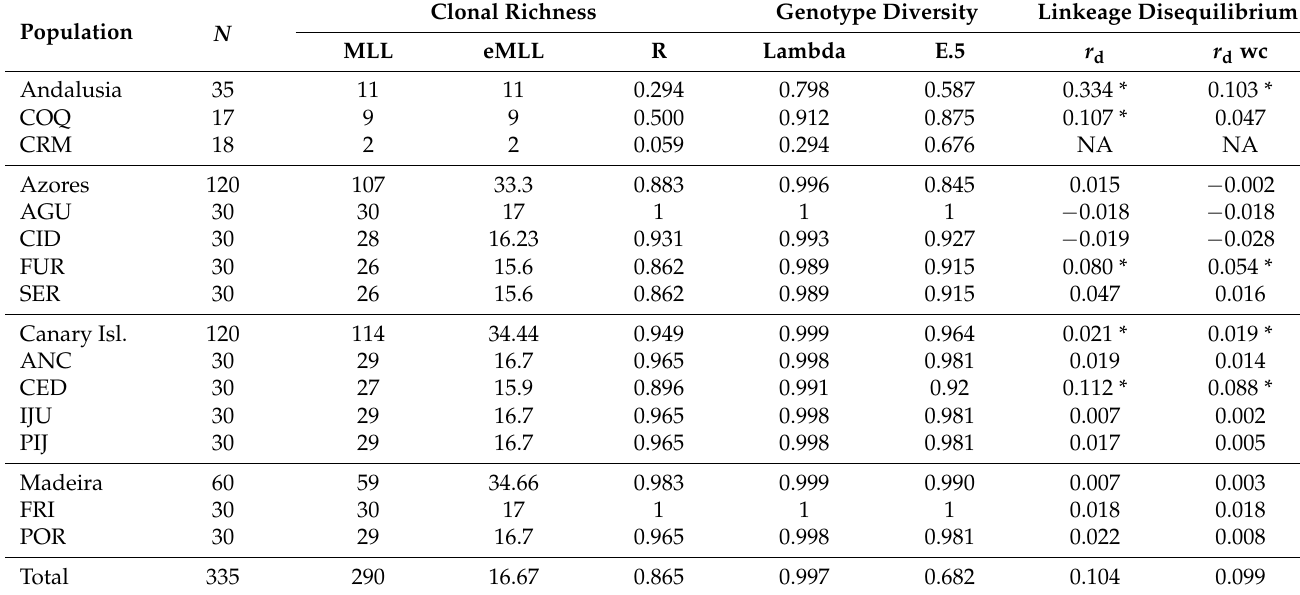
Table 2. Clonality descriptors in the populations of D. caudatum studied. Descriptors were separated into clonal richness, genotype diversity, and linkage disequilibrium. N, number of individuals sampled; MLL, number of different multilocus lineages; eMLL, number of expected MLLs at the smallest sample size ≥ 17 based on rarefaction [92]; R, clonal richness [93]; lambda, Simpson’s index [94]; E.5, evenness [95–97]; r d , standardized index of association [60]; r d wc, r d calculated considering only one individual per MLL per population.